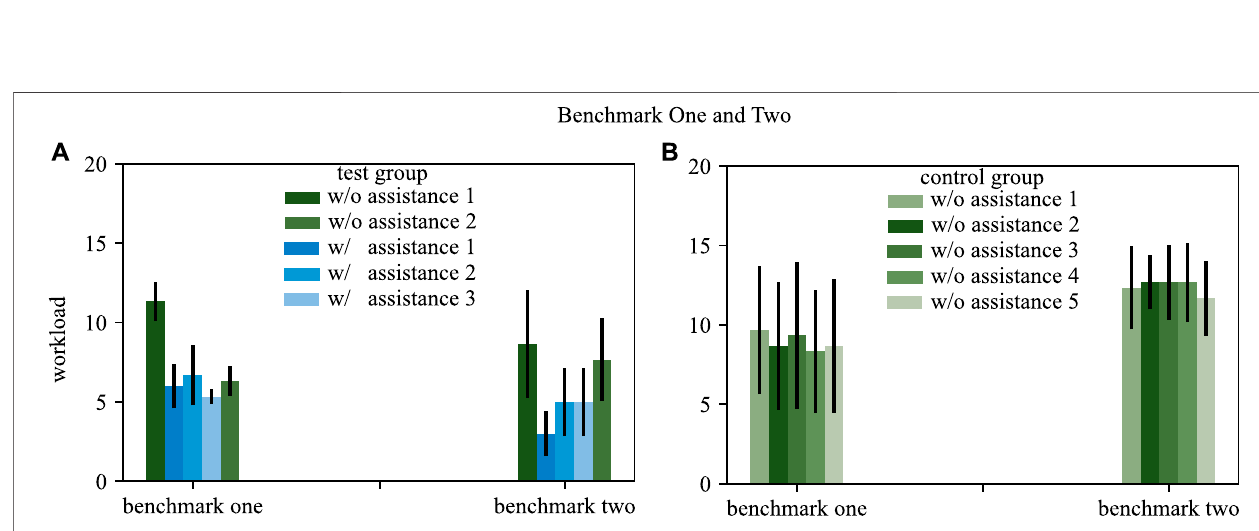
FIGURE 8 | The workload for both benchmarks is depicted, comparing the test group (A) and the control group (B) . Blue bars depict trials with assistance, green bars trials without assistance. The standard deviation is shown by black arrows.